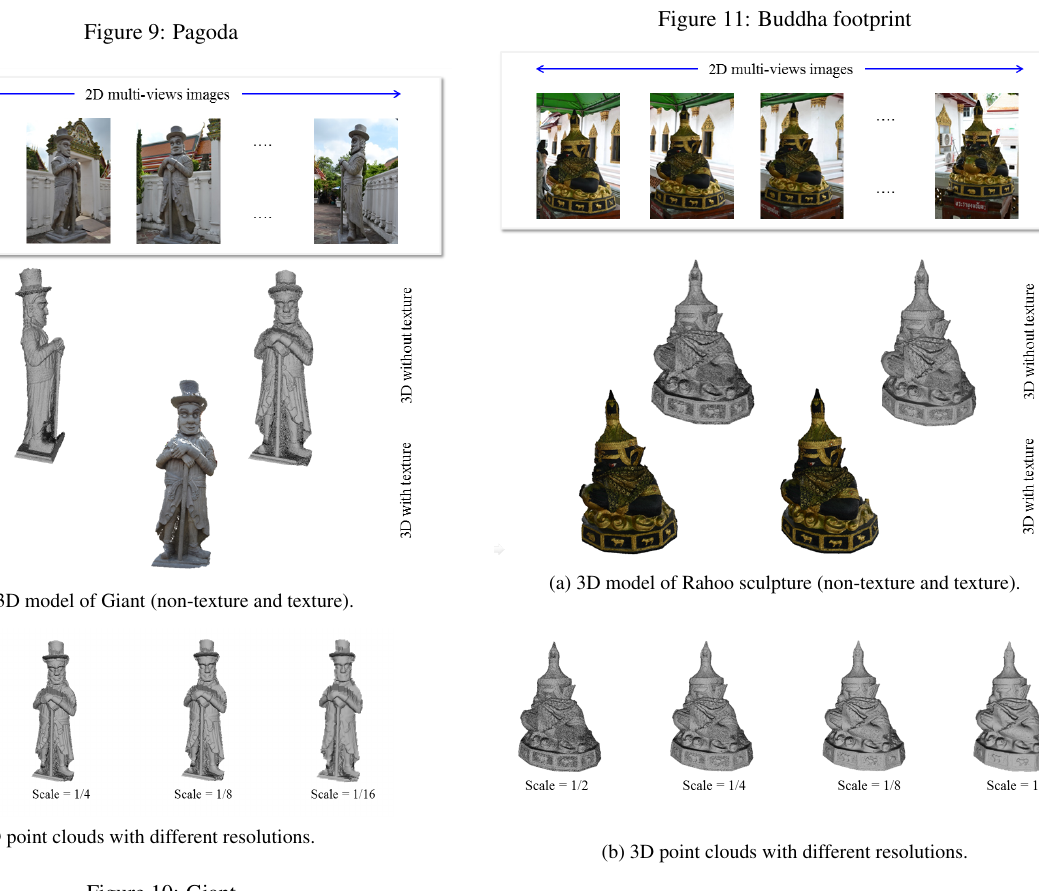
(b) 3D point clouds with different resolutions. Figure 11: Buddha footprint